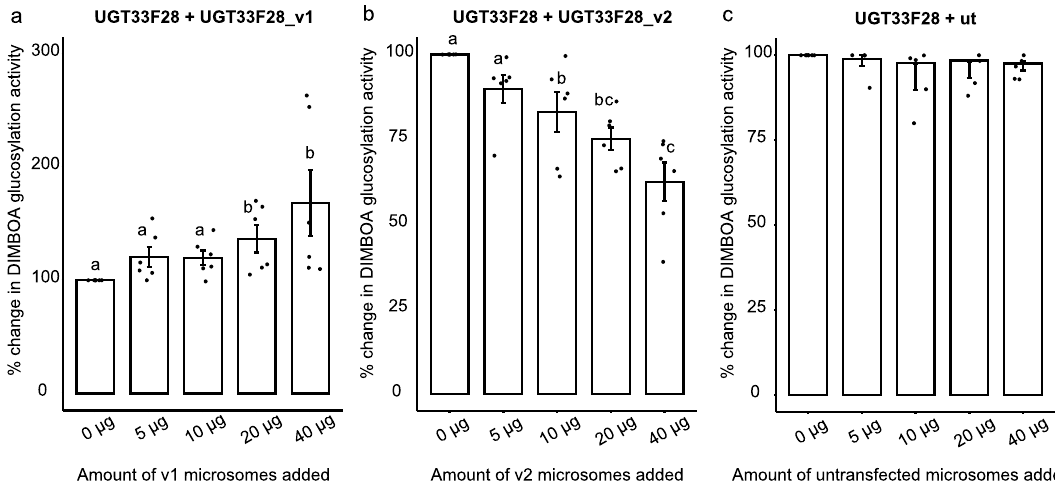
Figure 6. UGT33F28 variants modulate the DIMBOA glucosylation activity of the full-length protein. ( a – c ) In vitro enzymatic assays with microsomes from Hi5 cells producing SfUGT33F28 incubated with increasing amounts of microsomes from Hi5 cells producing SfUGT33F28 variant proteins towards DIMBOA as substrate. Microsomes from untransfected Hi5 cells (ut), which showed no activity towards DIMBOA, were used as a control and added in the same amount as the variant microsomes. DIMBOA-Glc peak areas were converted to relative activities with activity of the full-length protein set at 100%. Data are represented as mean ± SEM (n = 6). One-way repeated measures ANOVA was performed and the Holm–Sidak method was applied to carry out all pairwise comparisons. Small letters on the bars indicate a significant difference at P < 0.05. v1 variant 1, v2 variant